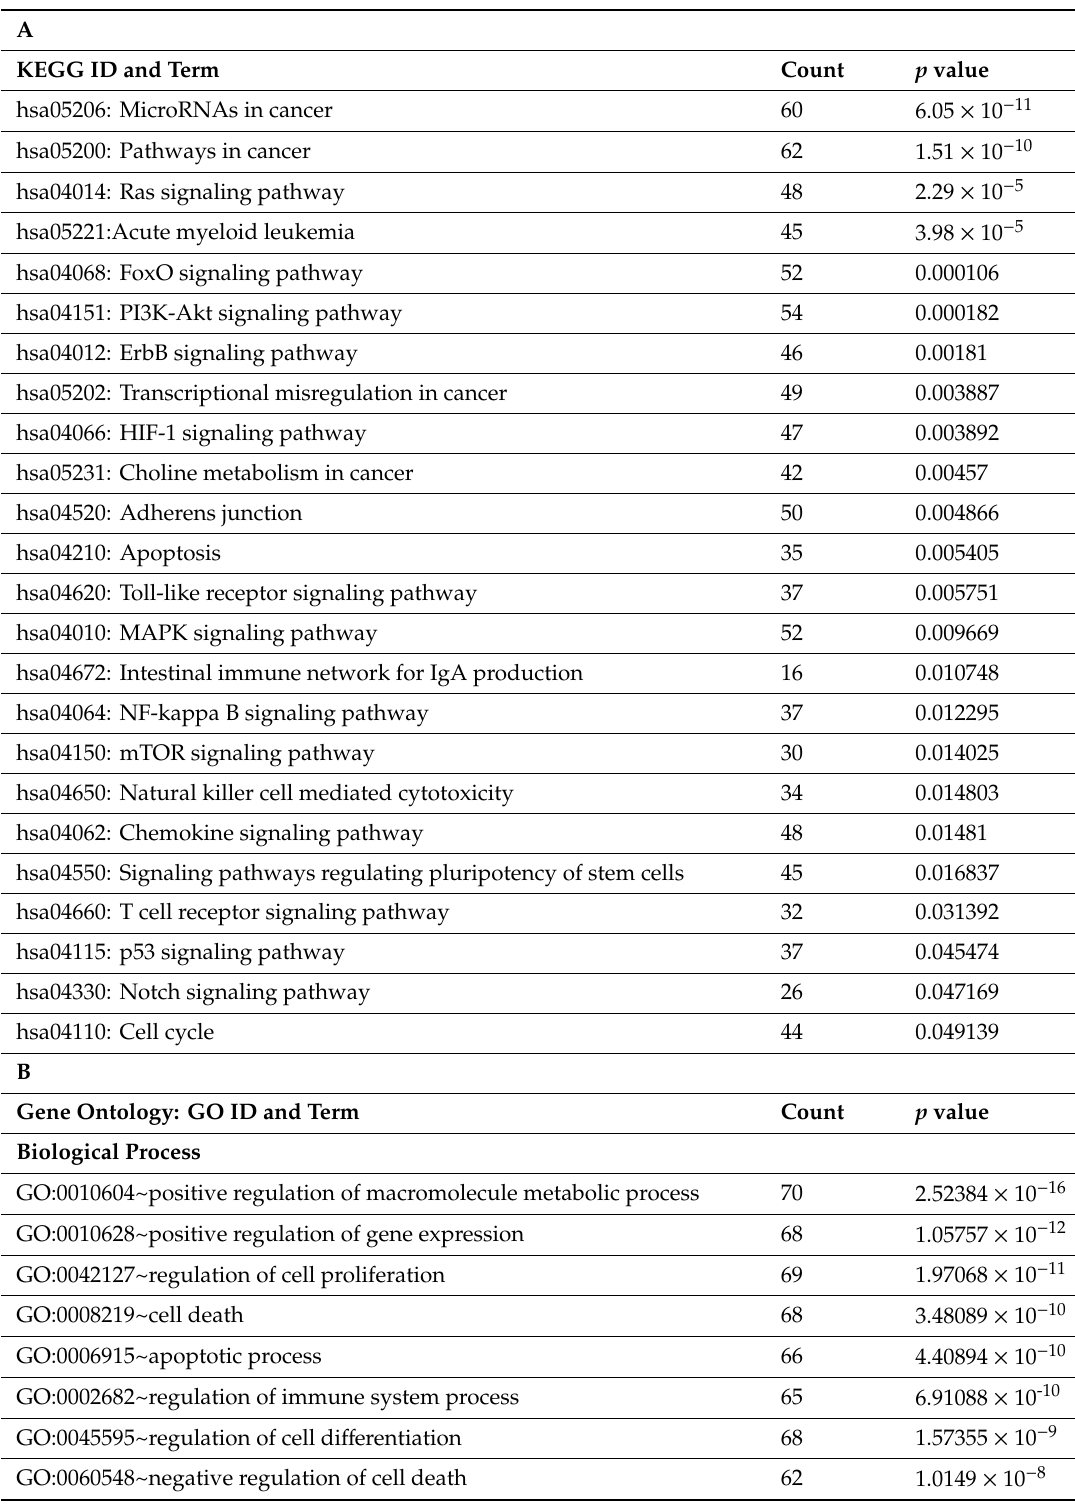
Table 3. Gene Ontology classification and Kyoto Encyclopedia of Genes and Genomes (KEGG) pathway enrichment analysis of di ff erentially expressed circulating bone marrow miRNAs in AML. A) KEGG Pathway Enrichment Analysis of di ff erentially expressed bone marrow circulating